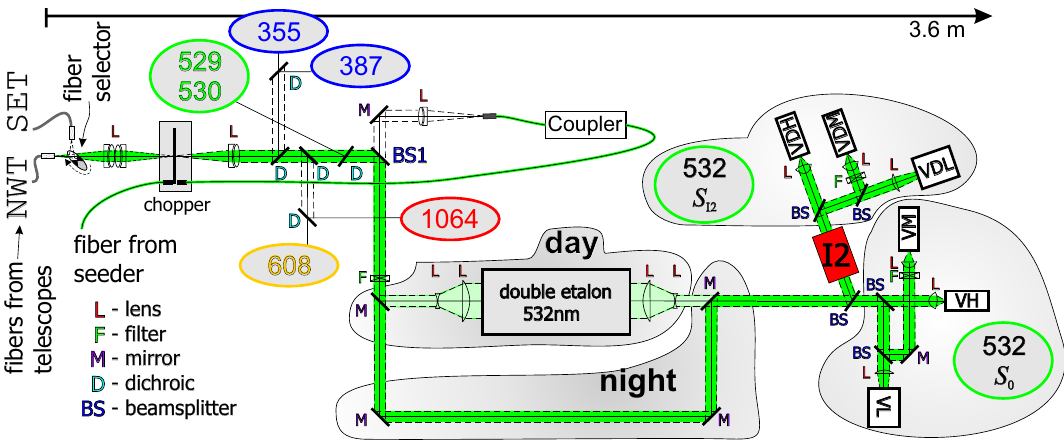
Fig. 4. Polychromatic detection system of the ALOMAR RMR lidar with emphasis on 532nm channels. Light from the telescopes (NWT or SET) is split by wavelength and intensity. Light for the DoRIS system is detected by the channel groups 532- S 0 and 532- S I can be operated during day using a double etalon system (bandpass ∼